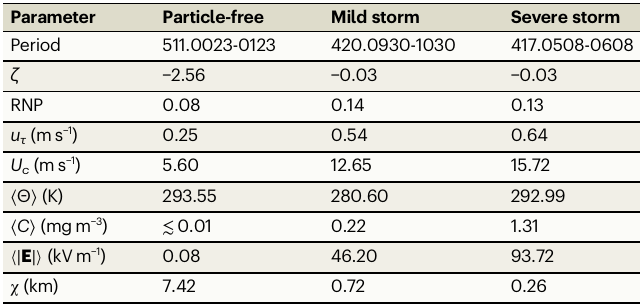
Table 1 | Summary of the main parameters of the selected three datasets Parameter Particle-free Mild storm